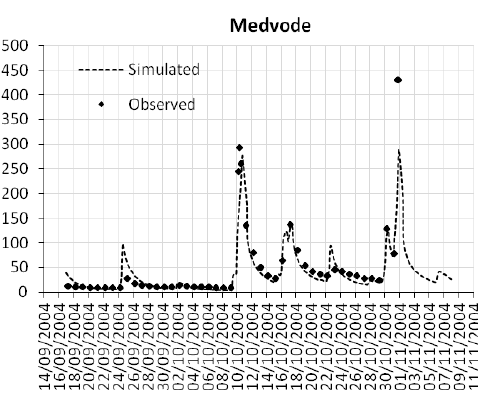
Fig. 5b. Model results for the validation period, 17/09/2004 to 08/11/2004. Medvode observed hydrograph is plotted with dots due Figure 5b: Model results for the validation period, 17/09/2004 to 08/11/2004. Medvode 4 to the daily time observed hydrograph is plotted with dots due to the daily time resolution. 5